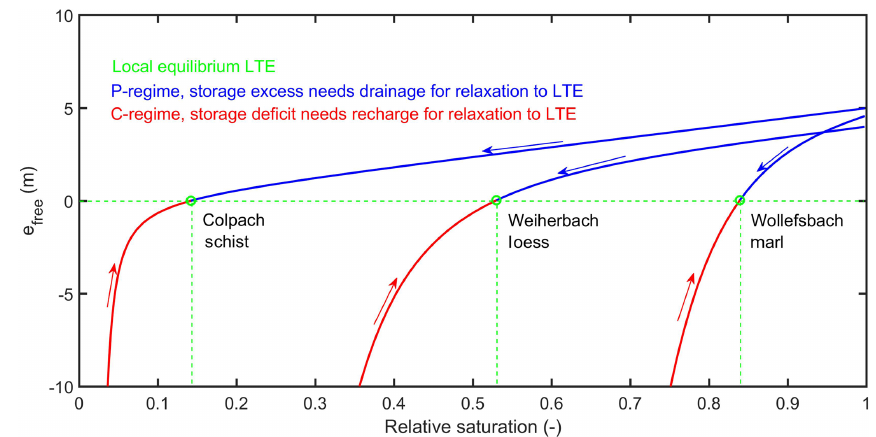
Figure 2. Weight-specific free energy state of the soil water storage, as defined in Eq. (8), plotted against the relative saturation of the three different soils, assuming a depth to groundwater of 10m. The green lines mark the local equilibrium state where the absolute value of the specific free energy is zero and the corresponding equilibrium saturations. Free energy in the P- and C-regimes is plotted in solid blue and red, respectively; the arrows indicate the way back to